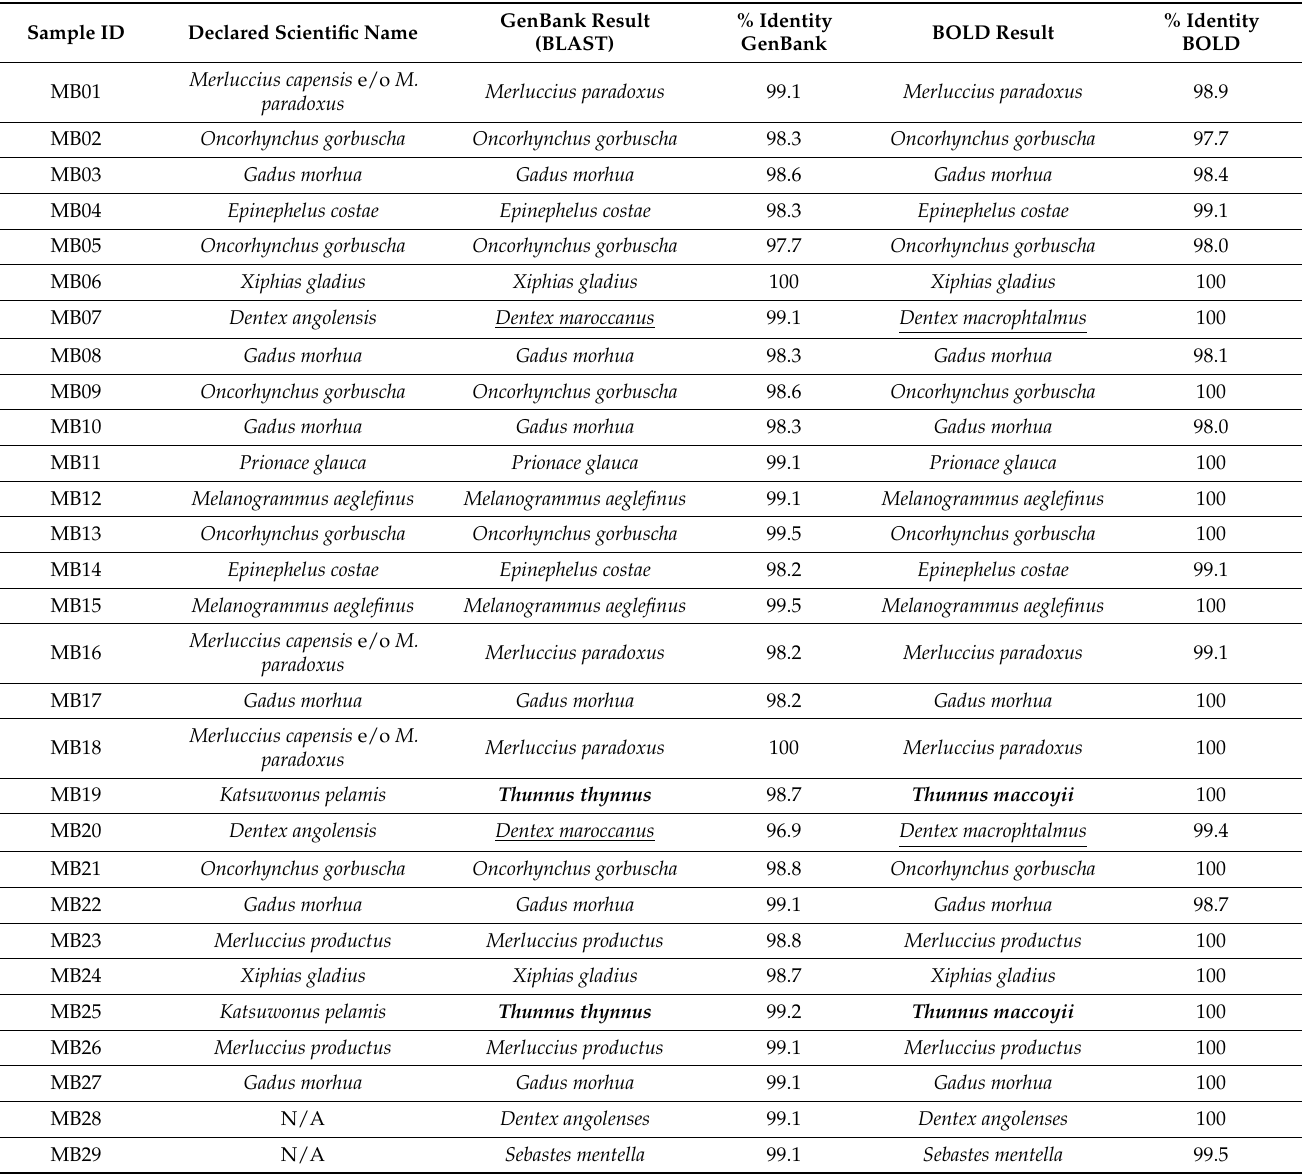
Table 2. Scientific names and identity percentage values of each sample are provided both for BLAST and BOLD alignment analysis. Major frauds: mislabeling at genus level; minor frauds: different species within the same genus. Major species substitutions in bold; minor substitutions underlined; N/A: Not